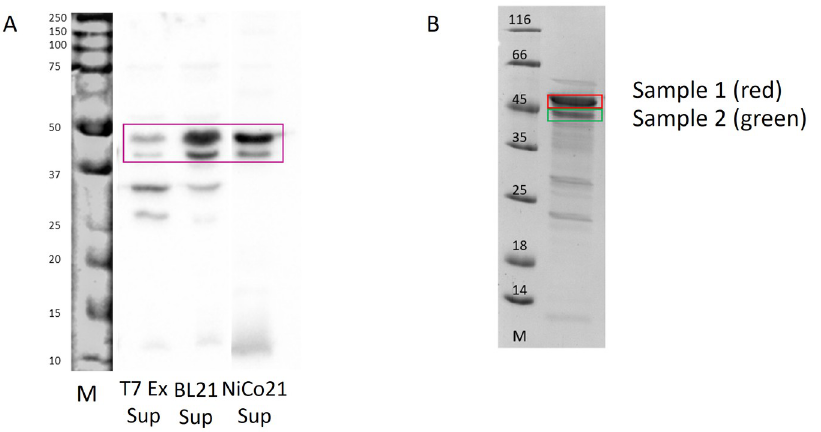
Fig 2. Protein conformation of RBBP6-p53BD. (A) : Shows western blot analysis of supernatant fractions of cell lysate from transformed Shuffle 1 T7 express, BL21 (DE3), and NiCo21 (DE3) E.coli cell lines using an anti- polyhistidine antibody. The RBBP6-p53BD is shown with a pink box. (B) : After SDS-PAGE the two protein bands indicated (red and green boxes) were isolated for trypsin digested LC-MS analysis after partial purification of the supernatant from NiCo21 (DE3) cells. The protein molecular weight marker (Thermo Scientific, 26610) has sizes in kDa, marked on the gel.